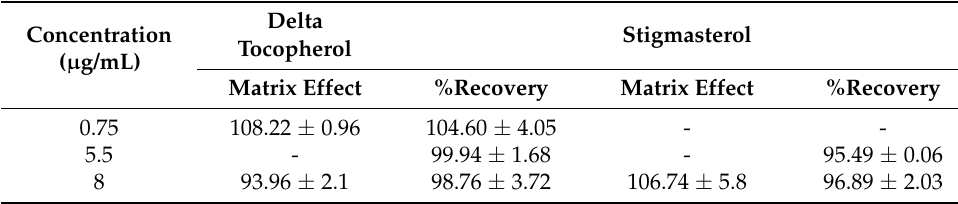
Table 4. Matrix effect and recovery studies for delta tocopherol and stigmasterol.